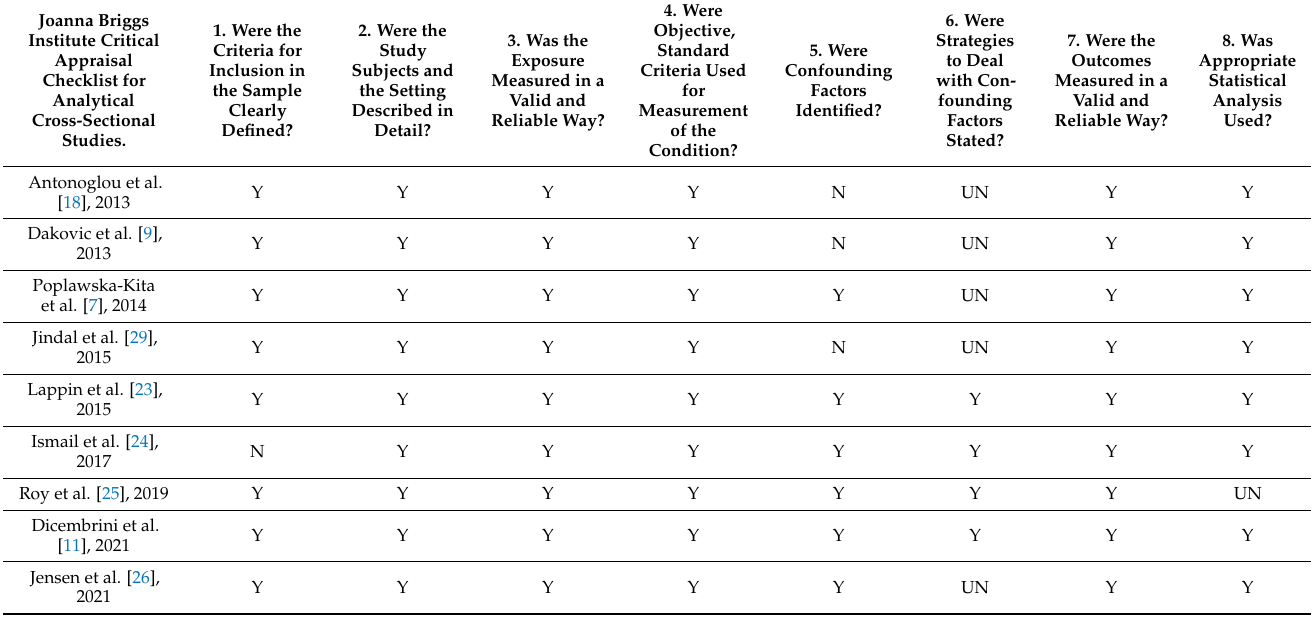
Table 1. Joanna Briggs Institute Critical Appraisal Checklist for Analytical Cross-Sectional Studies.